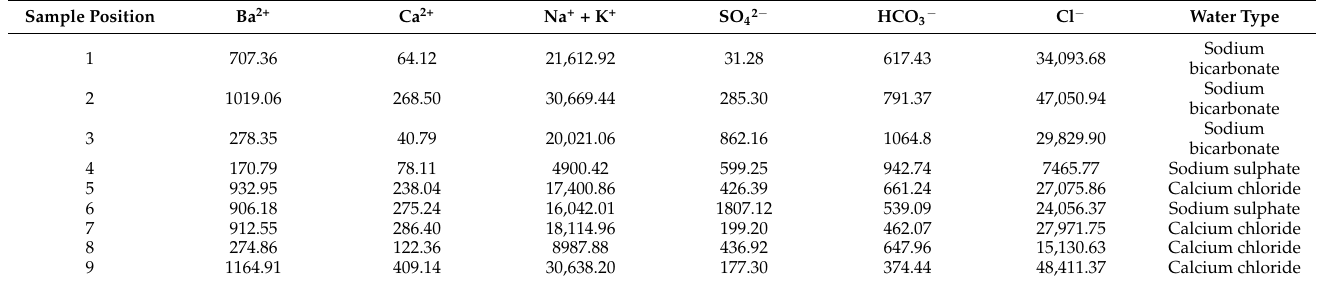
Table 2. Analysis results of water ion composition in different sample positions